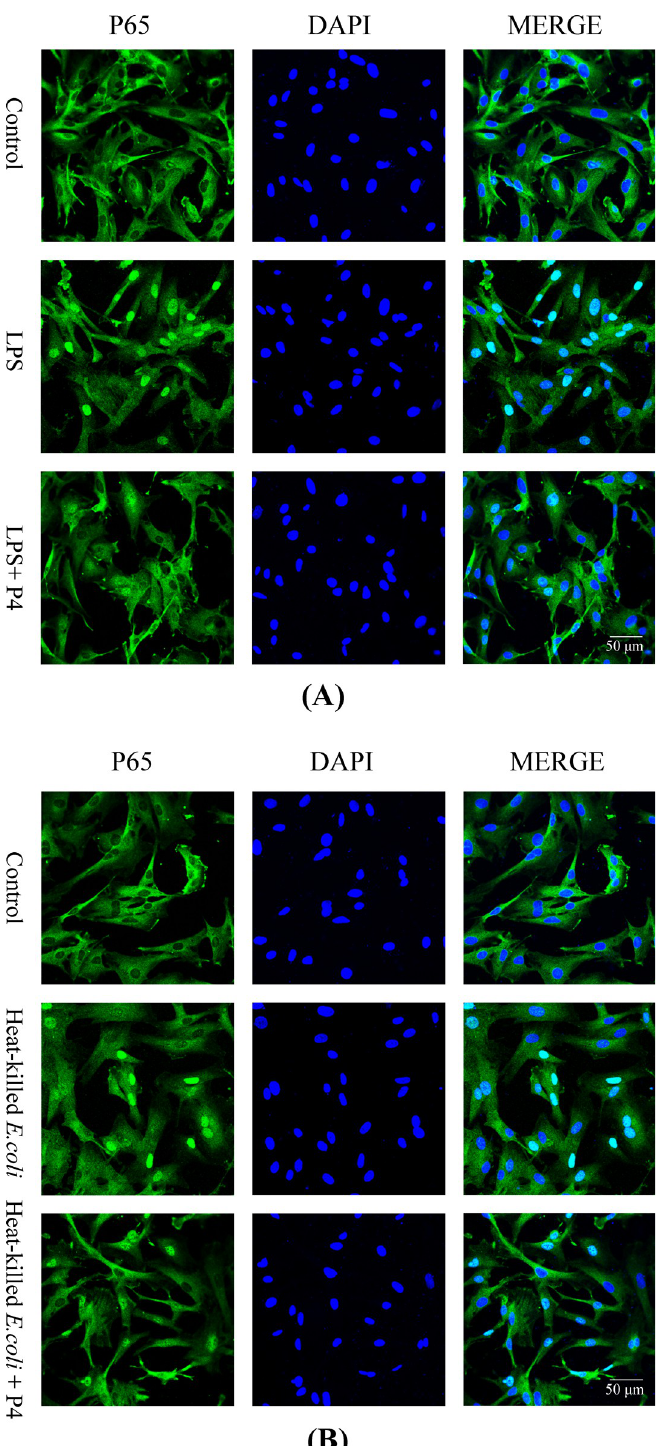
Fig 4. Progesterone inhibited nuclear translocation of P65 in primary bovine endometrial epithelial cells stimulated with lipopolysaccharide or E . coli . The cells were cotreated with 1 μ g/mL lipopolysaccharide and 3 ng/mL progesterone for 45 min (A), or cotreated with 1 × 10 8 CFU/mL heat-killed E . coli and 3 ng/mL progesterone for 120 min (B). LPS, lipopolysaccharide. P4, progesterone.